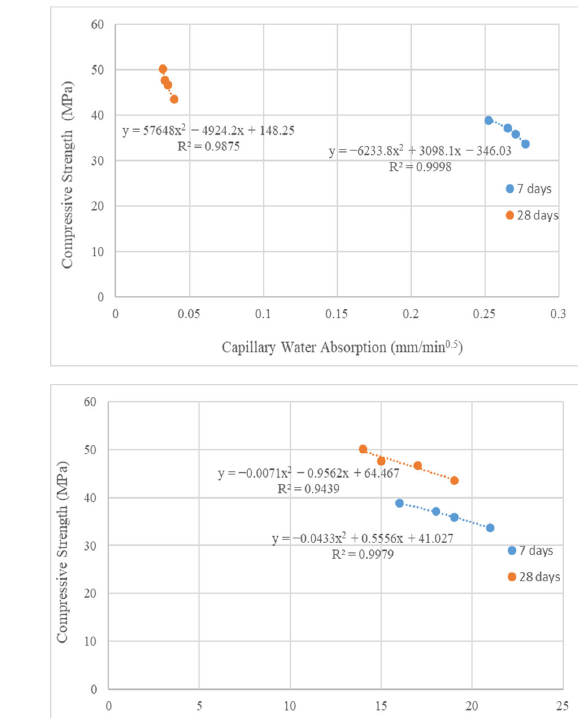
Figure 8. Water penetration of mixtures.